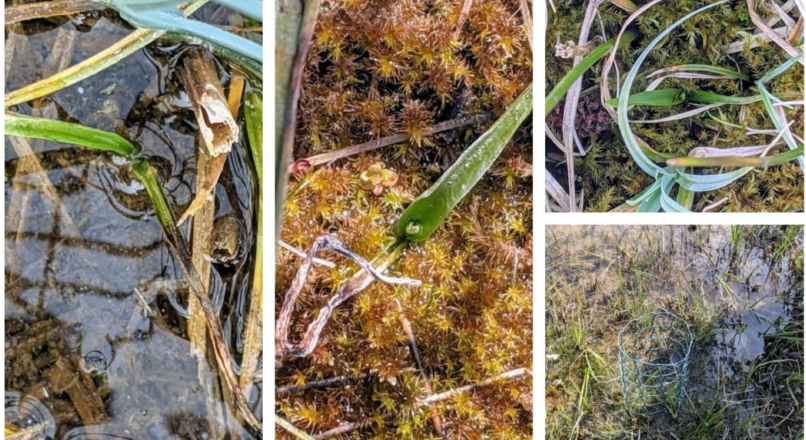
Figure 6. Dactylorhiza incarnata subsp. ochroleuca seedlings of different sizes (small, medium, and large) established after seven months of reintroduction to the flooded fen.